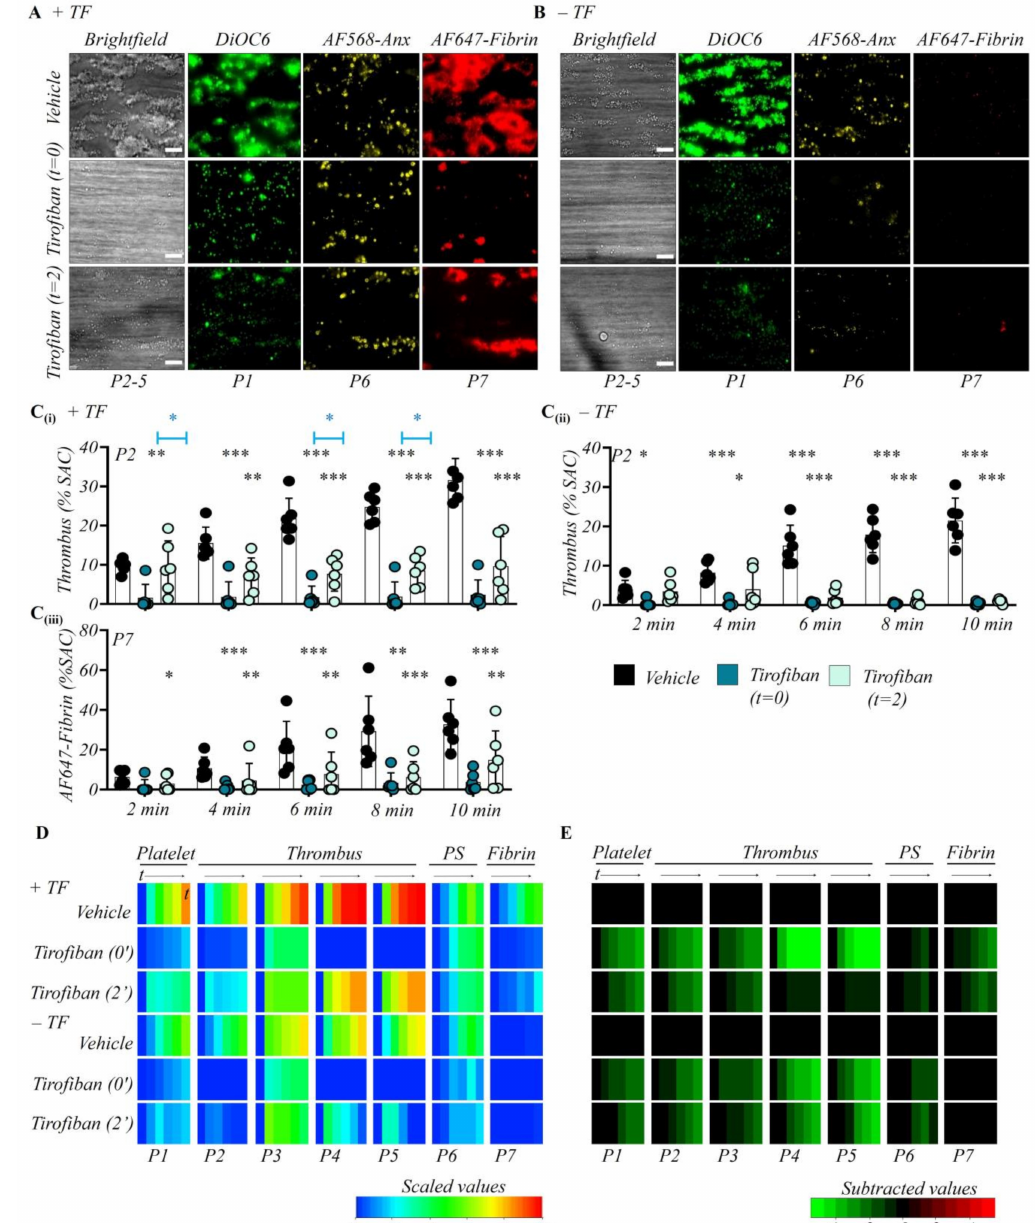
Figure 5. Involvement of integrin α IIb β 3 in thrombus formation independently of tissue factor. Citrated whole blood was labeled and co-perfused with recalcification medium over collagen